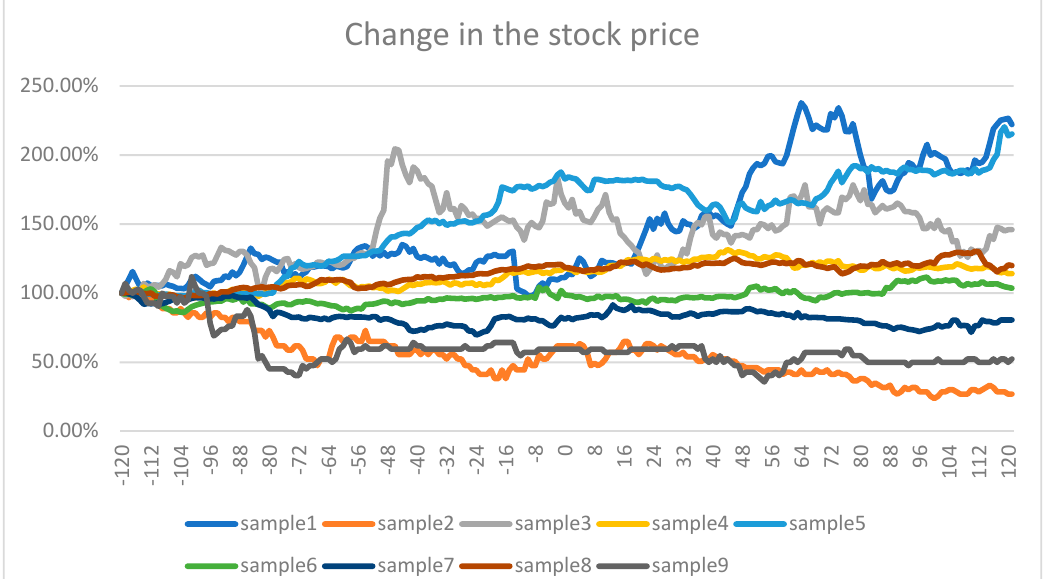
Figure 10 . Change in the stock price four months before and after the split date. Figure 10. Change in the stock price four months before and after the split